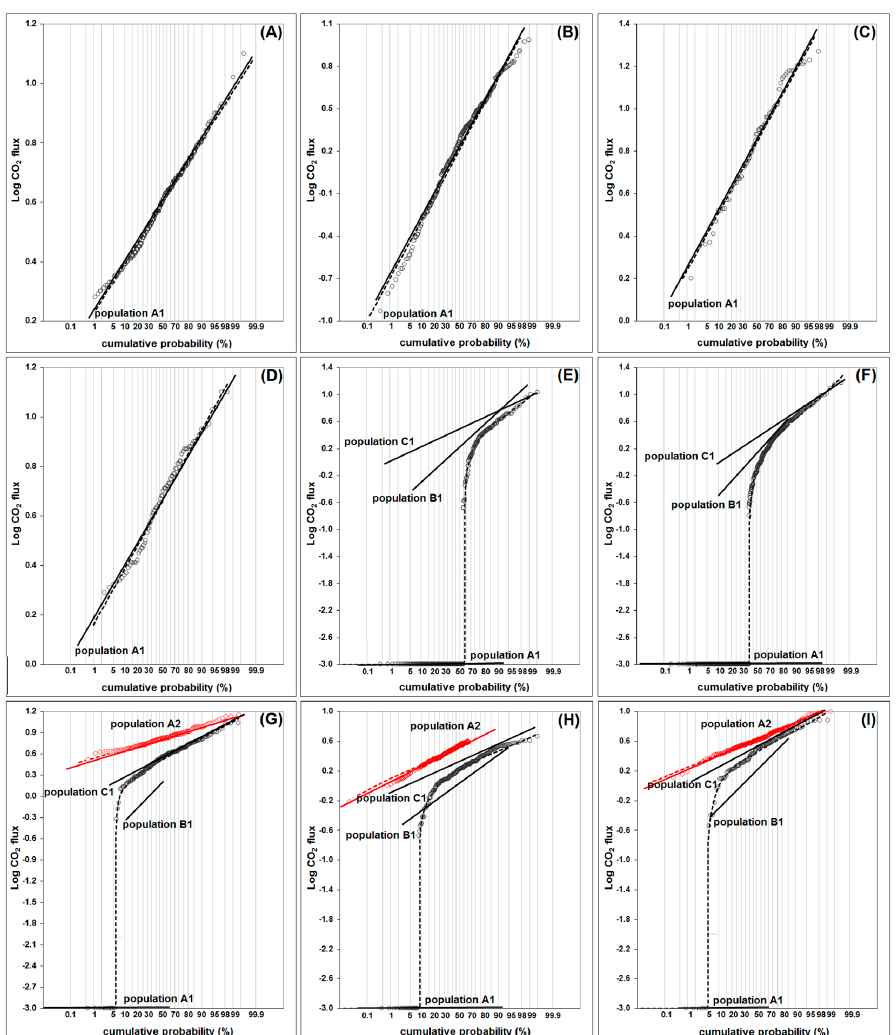
Figure 4. CO 2 fl ux probability plots for the first (red) and second (black) surveys made in the studied lakes for Corvo and Flores islands: ( A ) Caldeirão West; ( B ) Caldeirão East; ( C ) Branca; ( D ) Patos; ( E ) Negra; ( F ) Funda; ( G ) Comprida; ( H ) Rasa; and ( I ) Lomba. ( E ) Negra; ( F ) Funda; ( G ) Comprida; ( H ) Rasa; and ( I )